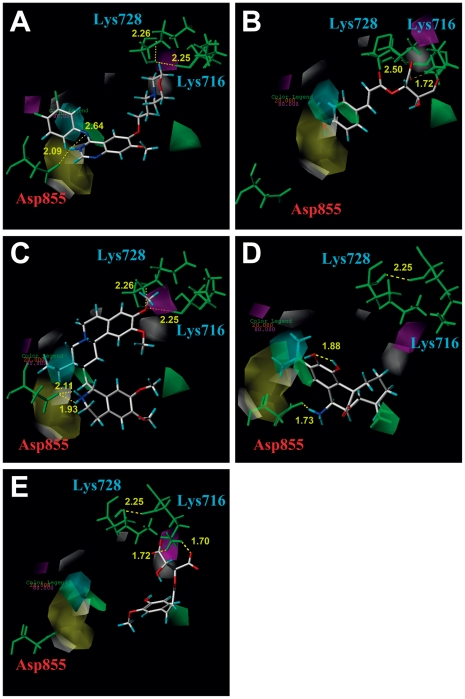
Structural contouring of different compounds to 3D-QSAR mapping.(A) Iressa, (B) 2-O-Caffeoyl tartaric acid, (C) Emetine, (D) Rosmaricine, and (E) 2-O-Feruloyl tartaric acid. 3D-QSAR features are represented by the following: steric field favor/disfavor (green/yellow), hydrophobic field favor/disfavor (cyan/white), and hydrogen bond donor avor/disfavor (magenta/orange). Bond distances are shown in yellow.